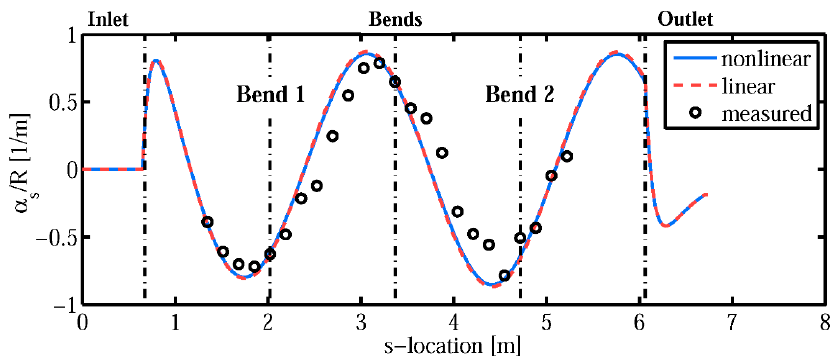
Figure 2. The α s /R profiles computed from the nonlinear model (solid line), the linear model (dash line) and the measured data (circles) for the S30 case. The dash ‐ dotted lines indicate the locations of meander apexes.